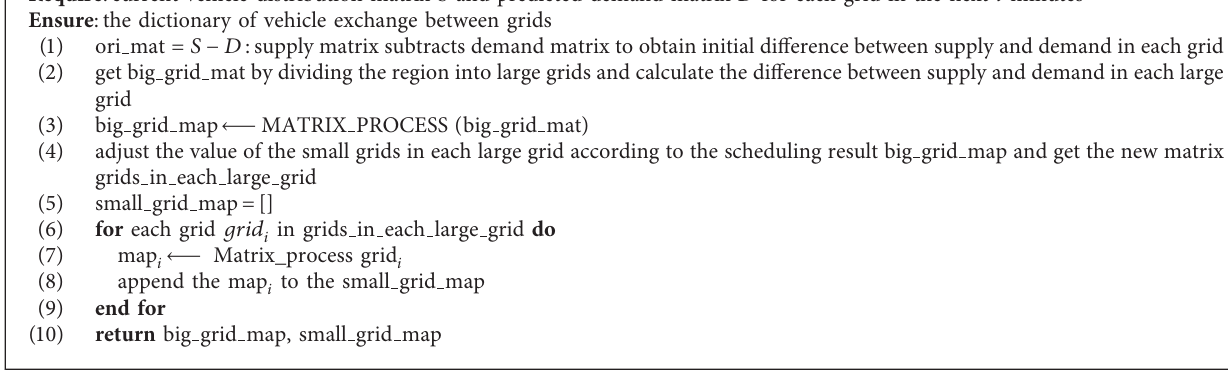
A LGORITHM 1: WoLF-PHC-based taxi dispatch